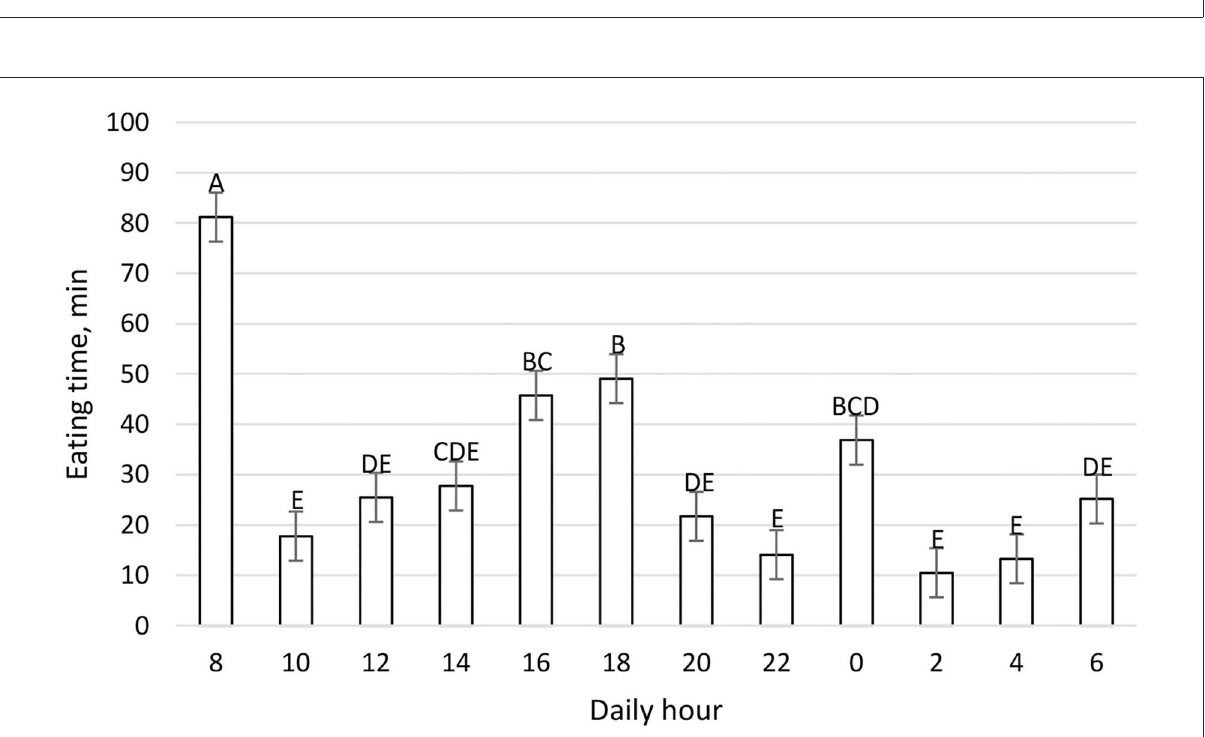
FIGURE2 Daily DMI (kg) pattern (LSM ± SE) on a 2h basis during the fecal sampling period. Letters for differences ≤ 0.05. Each time point refers to 2h intake. P-value < 0.01; SEM = 0.21.